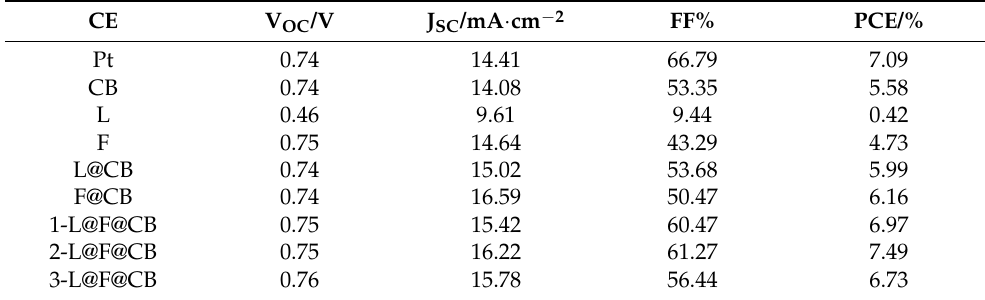
Table 3. Photovoltaic performance of DSSCs with different CEs under AM 1.5 G illumination at 100 mW · cm − 2